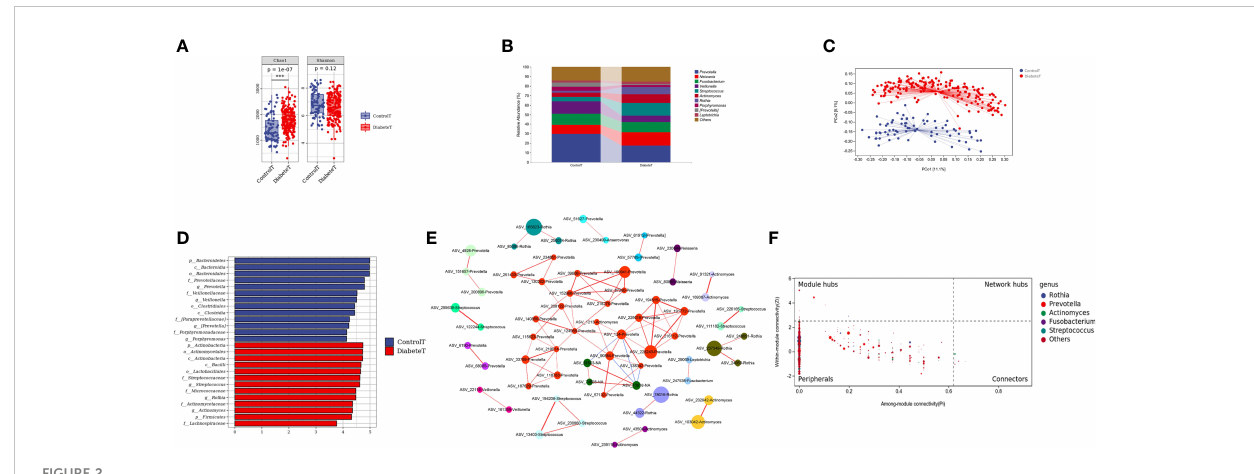
FIGURE 2 Distribution characteristics of oral microbiota in patients with type 2 diabetes. (Figure (A) is the a Diversity results. Figure (B) is the composition of oral fl ora in both groups (top 10 genera). Figure (C) shows the PCoA analysis results (each point in the fi gure represents a sample, and the percentage in the bracket of the coordinate axis represents the proportion of sample difference data that the corresponding coordinate axis can explain). Figure (D) is the LEfSe analysis results of oral microbiota in patients with T2DM (the ordinate in the fi gure was the taxon with signi fi cant differences between groups, and the abscissa is the logarithmic score of LDA analysis of each taxon. The taxon is sorted according to the score value. The longer the length is, the more signi fi cant the difference between the taxon is. The red bar chart is the diabetes group, the blue bar chart is the control group, and the LDA threshold is 3.5.), Figure (E) is the co-abundance network diagram of oral fl ora in patients with T2DM (Nodes with different colors represent a different module, the larger the nodes, the higher the relative abundance. Red lines represent the positive correlation; blue lines represent the negative correlation, and the thicker the lines, the higher the correlation coef fi cient). Figure (F) is the Zipi diagram of oral fl ora in patients with T2DM (The X and Y axes, respectively, represent the Pi and Zi values of nodes in the network. The node size is in direct proportion to its abundance. Different colors identify nodes in the top fi ve genera with the highest abundance. The legend on the right shows the bacteria corresponding to each color point.). *** represents